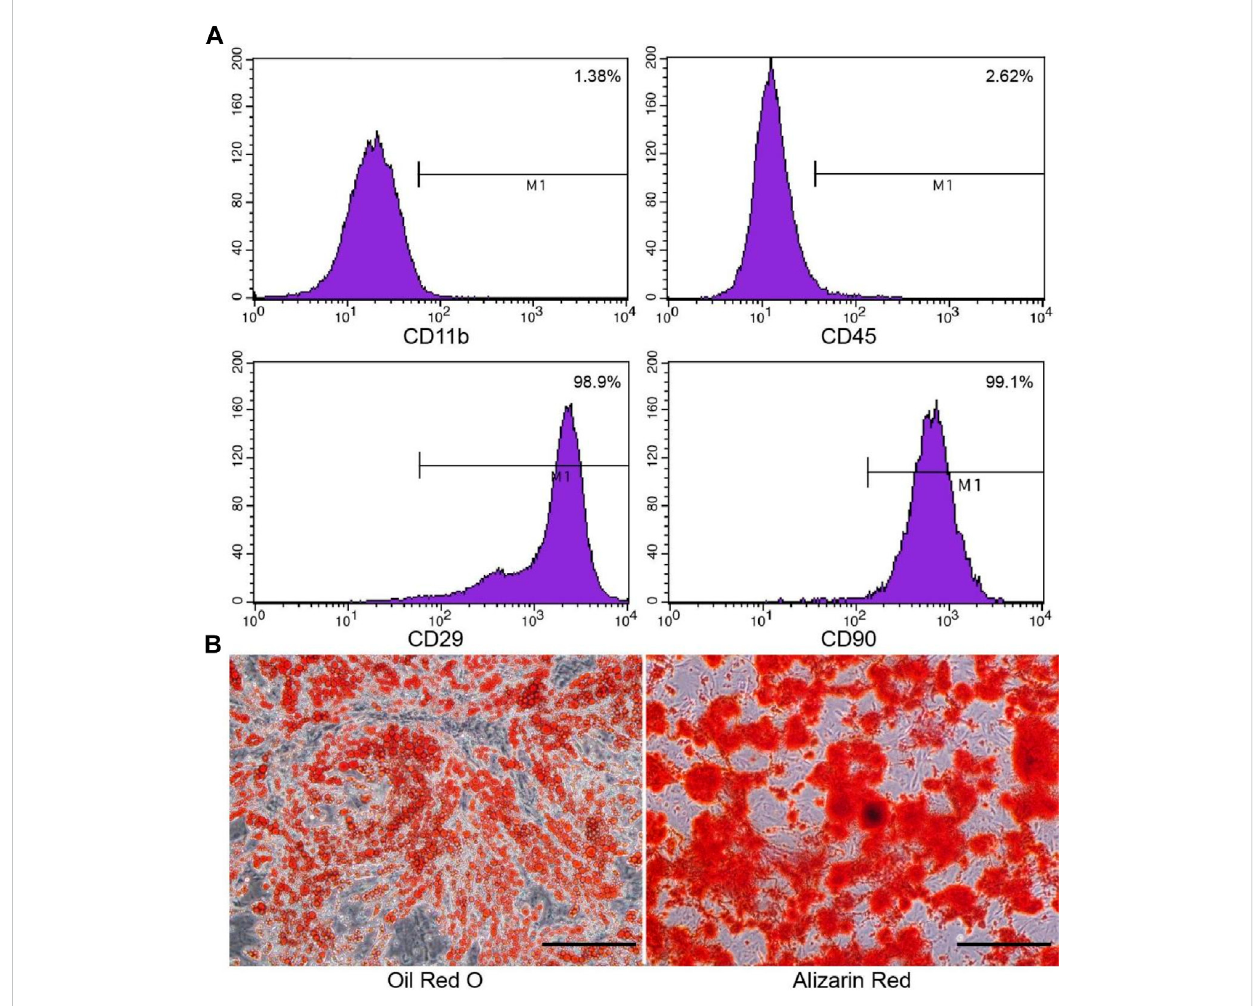
FIGURE 1 PhenotypiccharacterizationoftheculturedADSCsby fl owcytometryandstaining. (A) ADSCsexpressCD90andCD29,butdonotexpressCD11bor CD45, which is consistent with stem cells. (B) Oil-Red-O staining was used to identify adipogenic differentiation, and alizarin red was used to identify osteogenic differentiation. Scale bar = 200 μ m.